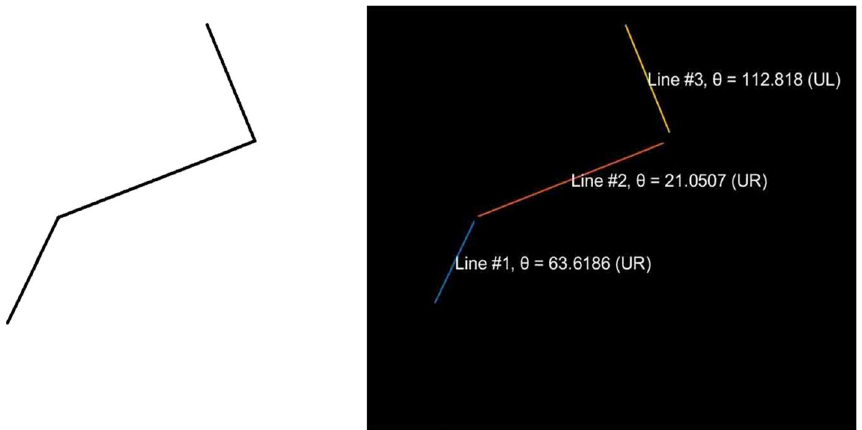
Figure 3. Example of successful Hough transform line detection.